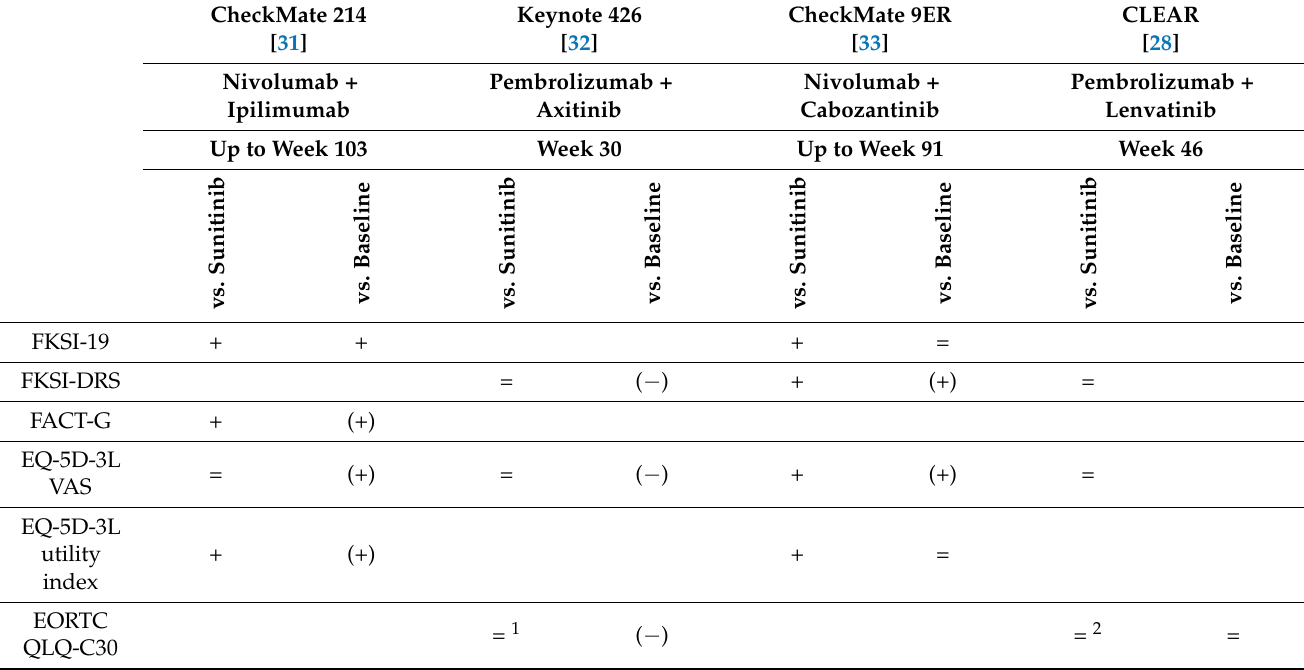
Table 3. Patient-reported outcomes (PRO) and quality of life (QoL). Adapted from [30]. CheckMate 214 [31] Nivolumab + Ipilimumab